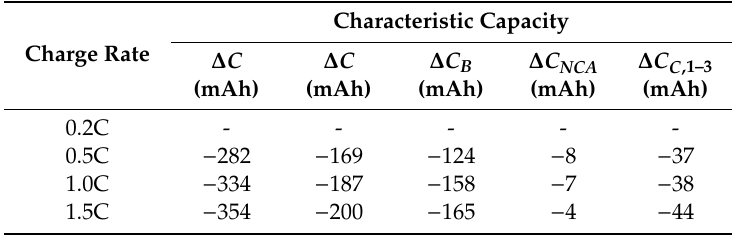
Table A3. Change of characteristic capacities after load cycle 14 at 0 ◦